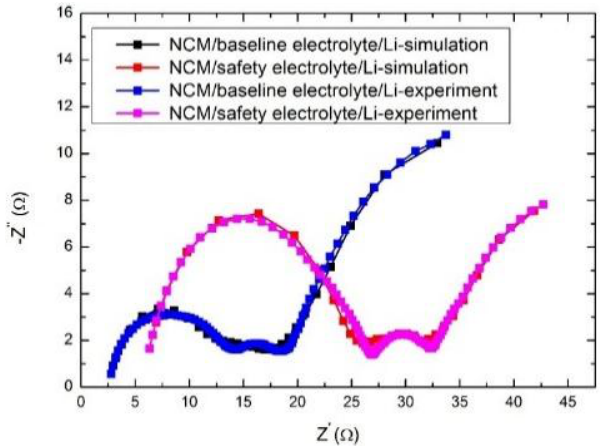
Figure 7. AC impedances of NCM/baseline electrolyte/Li and NCM/safety electrolyte/Li half cells. The half cells were cycled there times between 2.0 V and 4.2 V and then were discharged approximately to 3.75 V.